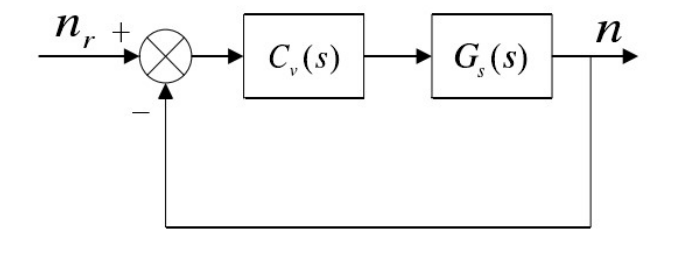
Figure 8. Closed-loop control model of ETS.